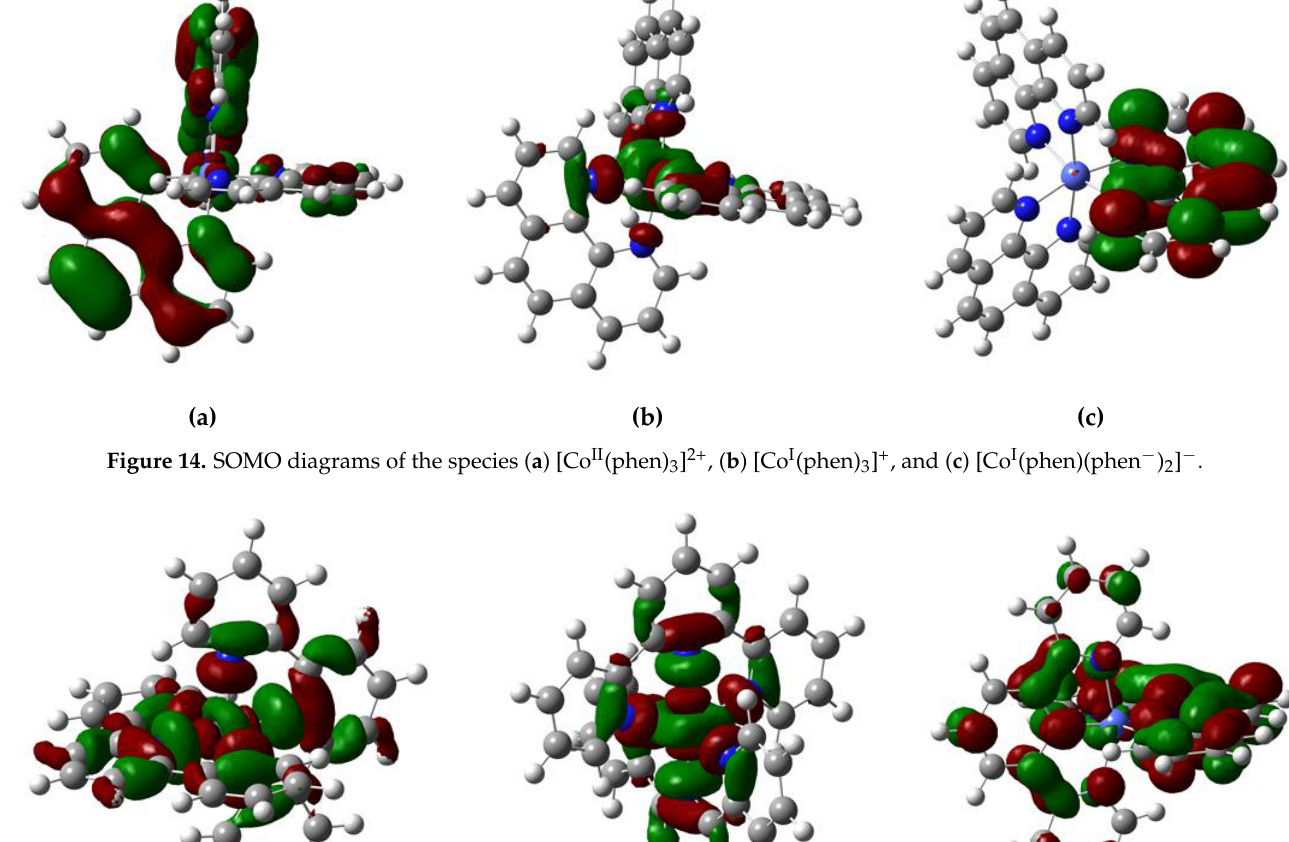
Figure 13. SOMO diagrams of the species ( a ) [Co II (bipy) 3 ] 2+ , ( b ) [Co I (bipy) 3 ] + , and ( c ) [Co I (bipy)(bipy − ) 2 ] − .